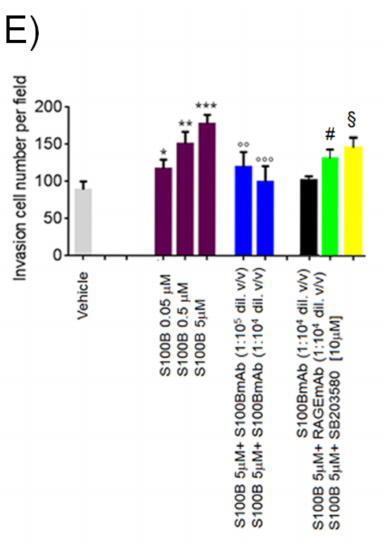
Figure 1. S100B stimulates Caco-2 cell proliferation, migration and invasion and its e ff ect is blocked by S100B monoclonal antibody (mAb). ( A ) 3-[4,5-dimethylthiazol-2-yl]-2,5-diphenyltetrazolium bromide (MTT) assay showing the e ff ect of S100B (0.005–5 µ M) in the presence or absence of S100BmAb (1:10 5 –1.10 4 v / v diluted), receptor for advanced glycation end products (RAGE)mAB (1:10 4 v / v diluted) and / or SB203580 p38 / pAkt inhibitor (10 µ M) on Caco-2 cell proliferation rate at 48 h. ( B ) Wound healing assay and ( D ) the relative quantification indicating a concentration-dependent inhibitory e ff ect of S100BmAb on cellular migration induced by S100B (0.05–5 µ M). The graphs show also RAGEmAb (1:10 4 v / v diluted) and / or SB203580 p38 / pAkt inhibitor (10 µ M) against S100B 5 µ M stimulus at 48 h. ( C ) Cell invasion assay and ( E ) the relative quantification of invading cells following S100B (0.05–5 µ M) exposure and relative inhibitory e ff ect of S100BmAb (1:10 5 –1:10 4 v / v diluted). Figures also show the e ff ect of RAGEmAb (1:10 4 v / v diluted) and SB203580 p38 / pAkt inhibitor (10 µ M) versus S100B 5 µ M stimulus. Results were expressed as mean ± standard error (SEM) of n = 6 experiments performed in triplicate. * p < 0.05; ** p < 0.01 and *** p < 0.001 versus vehicle; ◦◦ p < 0.01 and ◦◦◦ p < 0.001 versus S100B 5 µ M; # p < 0.05 and § p < 0.05 respectively versus S100B 5 µ M-treated cells. Scale bar: 100 µ m; Magnification